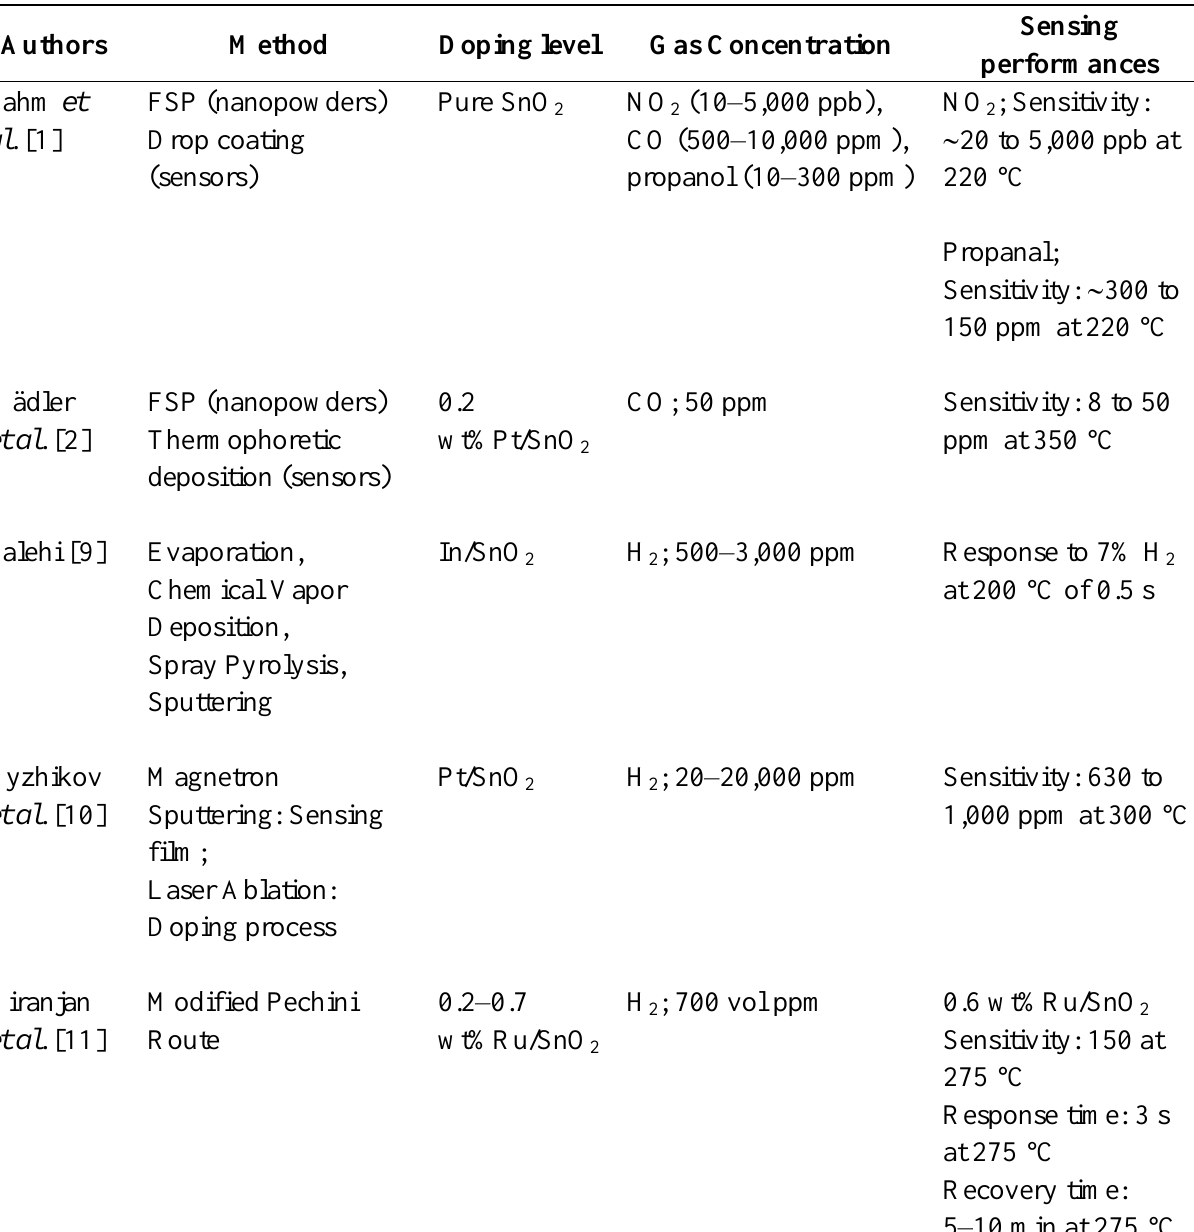
with several methods for gas 2